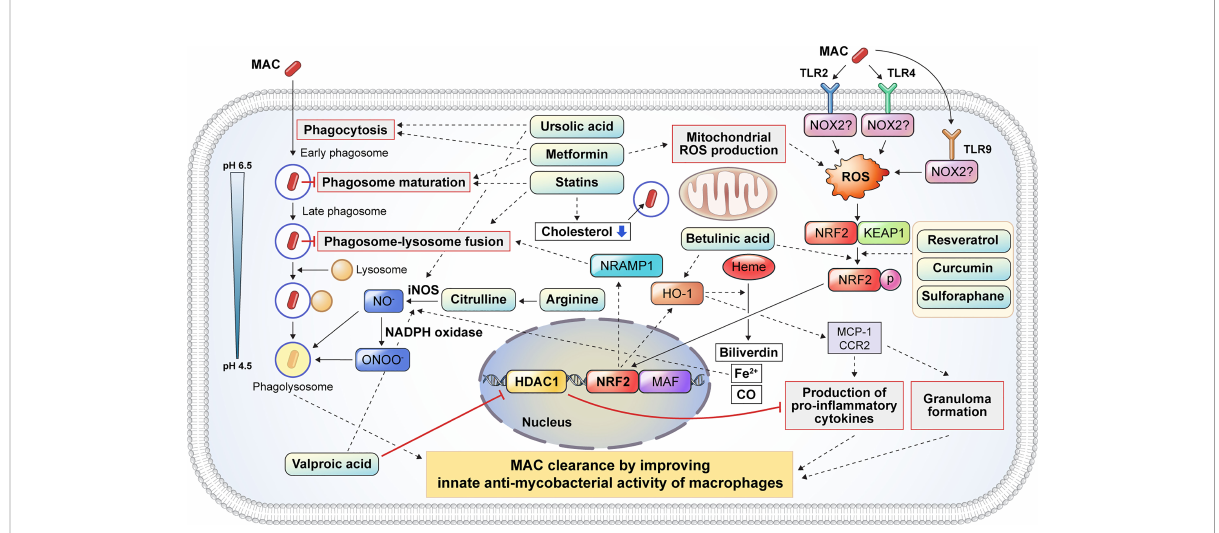
FIGURE 3 Proposed host-directed therapeutic agents enhance the host innate antimycobacterial activities against MAC infection. Several in fl ammatory signaling pathways are activated to eliminate intracellular mycobacteria. Host-directed therapeutic drugs may improve the clinical outcome of MAC infection by modulating the antimycobacterial response of macrophages, including phagocytosis, phagosome maturation, reactive oxygen and nitrogen species production, pro-in fl ammatory cytokine production, and granuloma formation. Metformin and UA promote the phagocytosis of extracellular mycobacteria. After phagocytosis, mycobacteria-containing phagosomes mature through a series of fusion and fi ssion events with endosomes before fusing with lysosomes. Several drugs, including statins and metformin, promote phagosome maturation. Additionally, statins induce phagosome – lysosome fusion and cholesterol depletion to promote the intracellular killing of MAC. Citrulline and arginine promote nitric oxide (NO) production following the conversion of arginine to citrulline in macrophages via iNOS. Furthermore, UA and VA promoted the production of NO by upregulating iNOS. VA inhibits the expression of HDAC1, which suppresses the production of pro- in fl ammatory cytokines. Mycobacterial infection induces ROS production through the activation of TLR2 and TLR4 signaling which initiates the dissociation of KEAP1 from NRF2. Several drugs, such as resveratrol, curcumin, and betulinic acid, promote the dissociation of NRF2 from KEAP1, leading to the nuclear translocation of NRF2 which activates NRAMP1 and HO-1. The activation of NRAMP1 promotes phagosome – lysosome fusion, leading to the intracellular killing of mycobacteria in macrophages. In addition, HO-1 activation promotes granuloma formation, which restricts mycobacterial infection. HO-1 catalyzes heme into biliverdin, Fe 2+ , and CO. Fe 2+ promotes NO production from arginine via iNOS. HO-1 also promotes the production of pro-in fl ammatory cytokines and granuloma formation through MCP1 and CCR2 signaling. In summary, the induction of phagocytosis, phagosome maturation, ROS/NO production, NF- kb signaling, NRF2 – KEAP1, and HO-1 pathways by numerous drugs facilitates the restriction and clearance of MAC and subsequently improves the clinical outcomes. MAC, Mycobacterium avium complex; UA, ursolic acid; iNOS, inducible nitric oxide synthase; VA, valproic acid; HDAC1, histone deacetylase 1; ROS, reactive oxygen species; TLR, Toll-like receptor; KEAP1, Kelch-like ECH-associated protein 1; NRF2, nuclear factor-erythroid factor 2-related factor 2; NRAMP1, natural resistance-associated macrophage protein 1; HO-1, heme oxygenase-1; MCP1, monocyte chemoattractant protein 1; CCR2, C-C chemokine receptor type 2; NF, nuclear